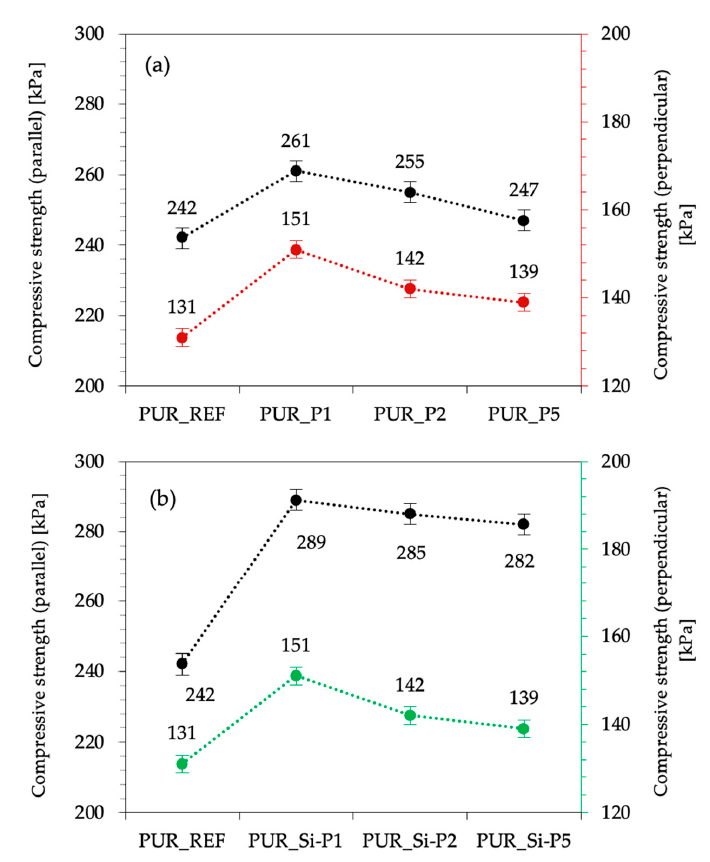
Figure 9. Effect of plum ( a ) and silanized plum ( b ) fillers’ content on the compressive strength of PUR foams.